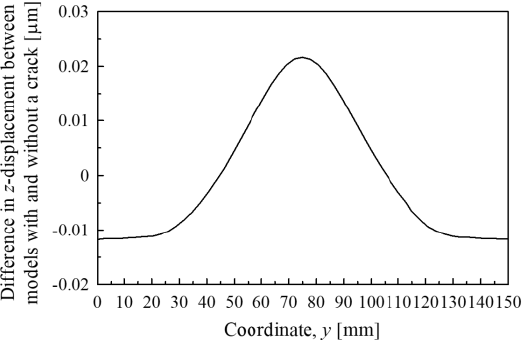
Figure 19. The di ff erence in the z -displacement between the models with and without a crack of Model 3D along trace line Figure 19. The difference in the z -displacement between the models with and without a crack of Model 3D along trace line 3. Figure 19. The difference in the z -displacement between the models with and without a crack of Model 3D along trace line 3. Figure 19. The difference in the z -displacement between the models with and without a crack of Model 3D along trace line 3.